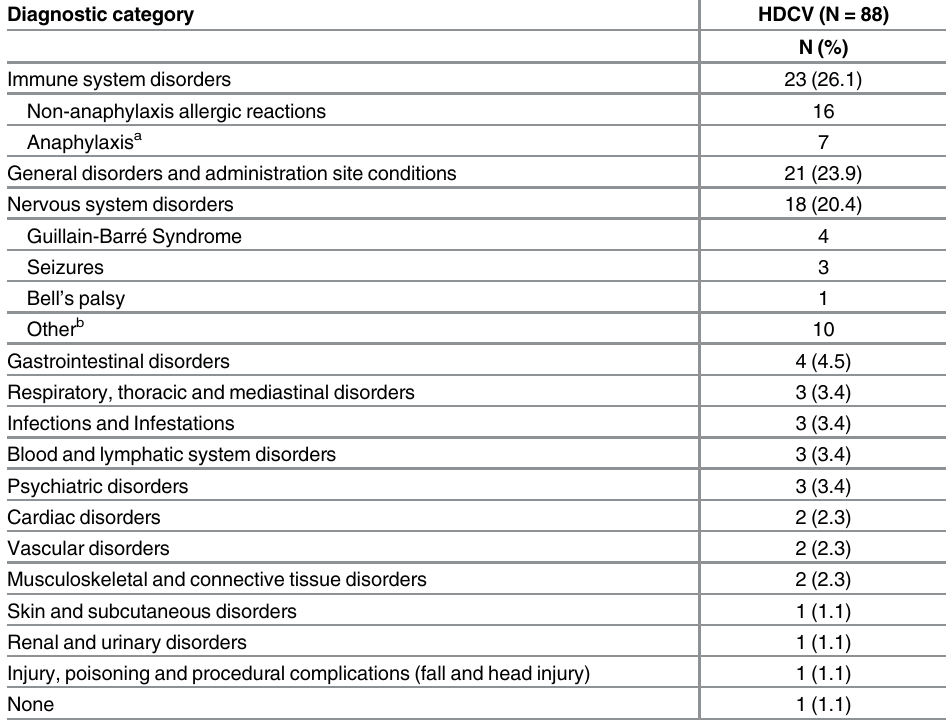
Table 4. Diagnostic categories for non-death serious reports of adverse events after human diploid cell rabies vaccine (HDCV, Imovax) vaccine in VAERS among persons vaccinated January 1, 1990 through July 31,